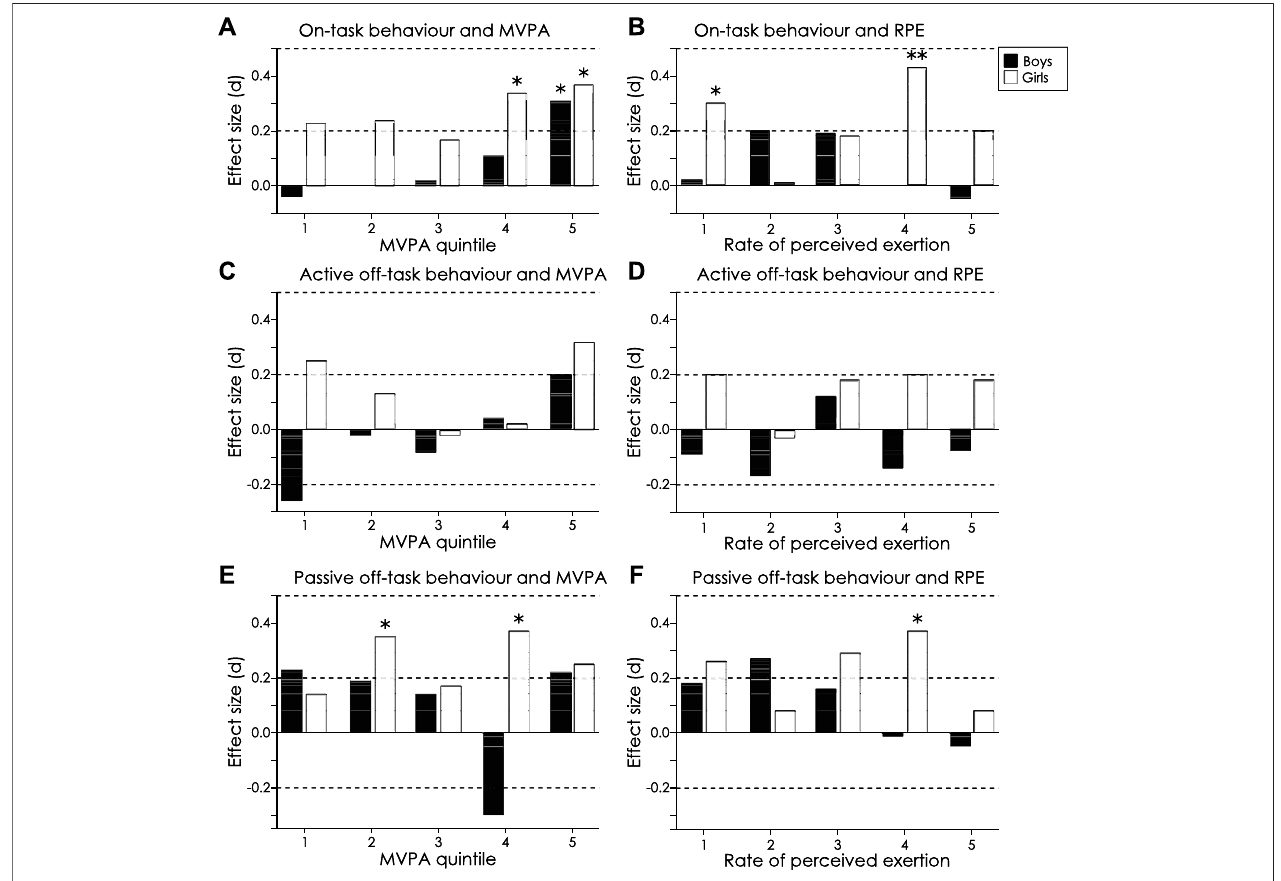
FIGURE 6 | Change in behaviour in response to objective and subjective measures of physical activity intensity, by sex. (A) On-task behaviour and MVPA (B) On- task behaviour and RPE (C) Active off-task behaviour and MVPA (D) Active off-task behaviour and RPE (E) Passive off-task behaviour and MVPA (F) Passive off-task behaviour and RPE. Note. MVPA (cid:1) Moderate-to-vigorous physical activity. Effect sizes have been transformed so that positive numbers re fl ect favourable effects (more on-task behaviour,less off-task behaviour). Small ( d (cid:1) 0.2), medium ( d (cid:1) 0.5), and large ( d (cid:1) 0.8) effect sizes are indicated by the dashed grid lines. * p ≤ 0.05, ** p ≤ 0.01, and *** p ≤